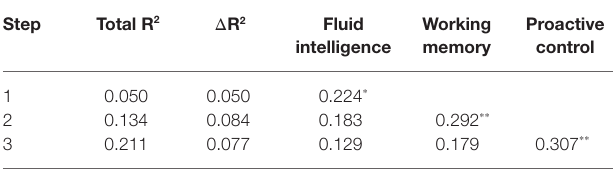
TABLE 4 | Hierarchical regression analyses predicting math